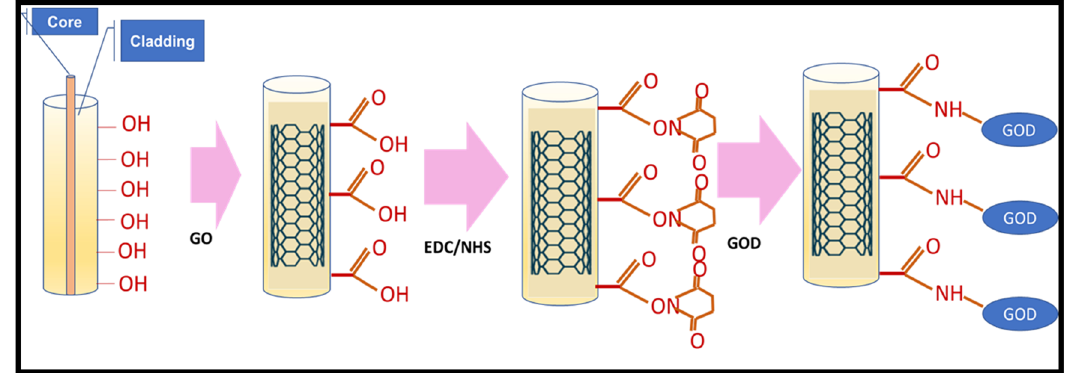
Figure 21: Schematic illustration of a fi ber - optic biosensor based on GO - coated LPFG: FPLG surface with hydroxylation treatment, GO deposition, EDC/NHS - treated, and GOD - immobilized LPFG.